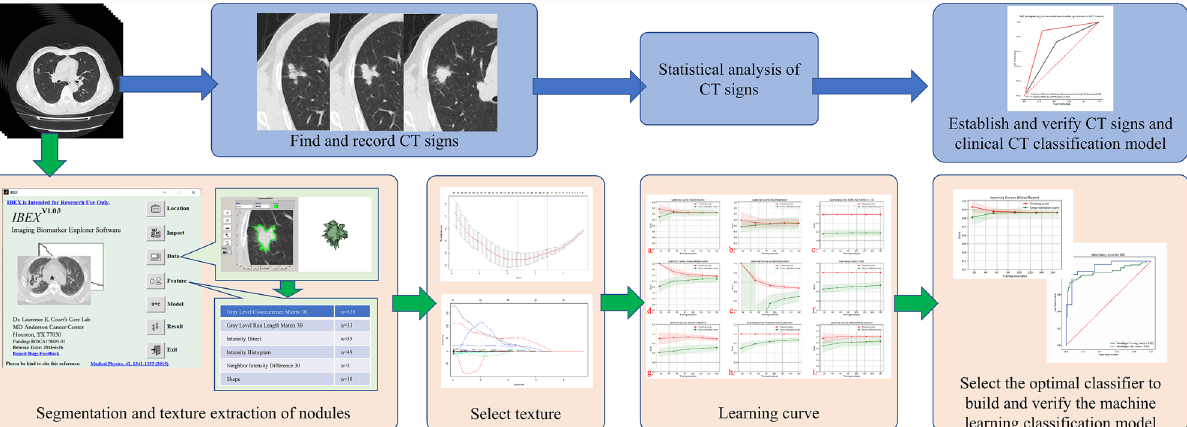
Figure 1. Research path map. Blue path, routine clinical CT diagnosis process. The features were found from CT images, and the differential diagnosis models were established to evaluate CT features and clinical CT diagnosis. Green path, machine learning process. The texture features are extracted from CT images by IBEX software. The extracted texture features are reduced by LASSO regression. The best classifier is selected by learning curves of machine learning, and the machine learning classification model is established and tested.